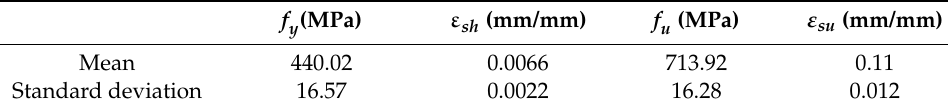
Table 2. Yield and ultimate stress of reinforcing steel.